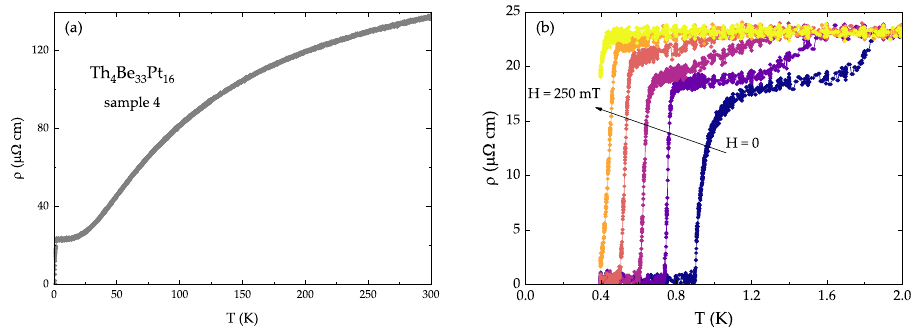
Figure 4. Electrical resistivity of Th 4 Be 33 Pt 16 . ( a ) H = 0 and ( b ) 0 ≤ H ≤ 250 mT data. High-temperature region indicates metallic behavior of Th 4 Be 33 Pt 16 , while a drop around T = 0.9 K marks entrance into superconducting state. The additional transition around T = 1.8 K can be attributed to the secondary phase Be 21 Pt 5 .